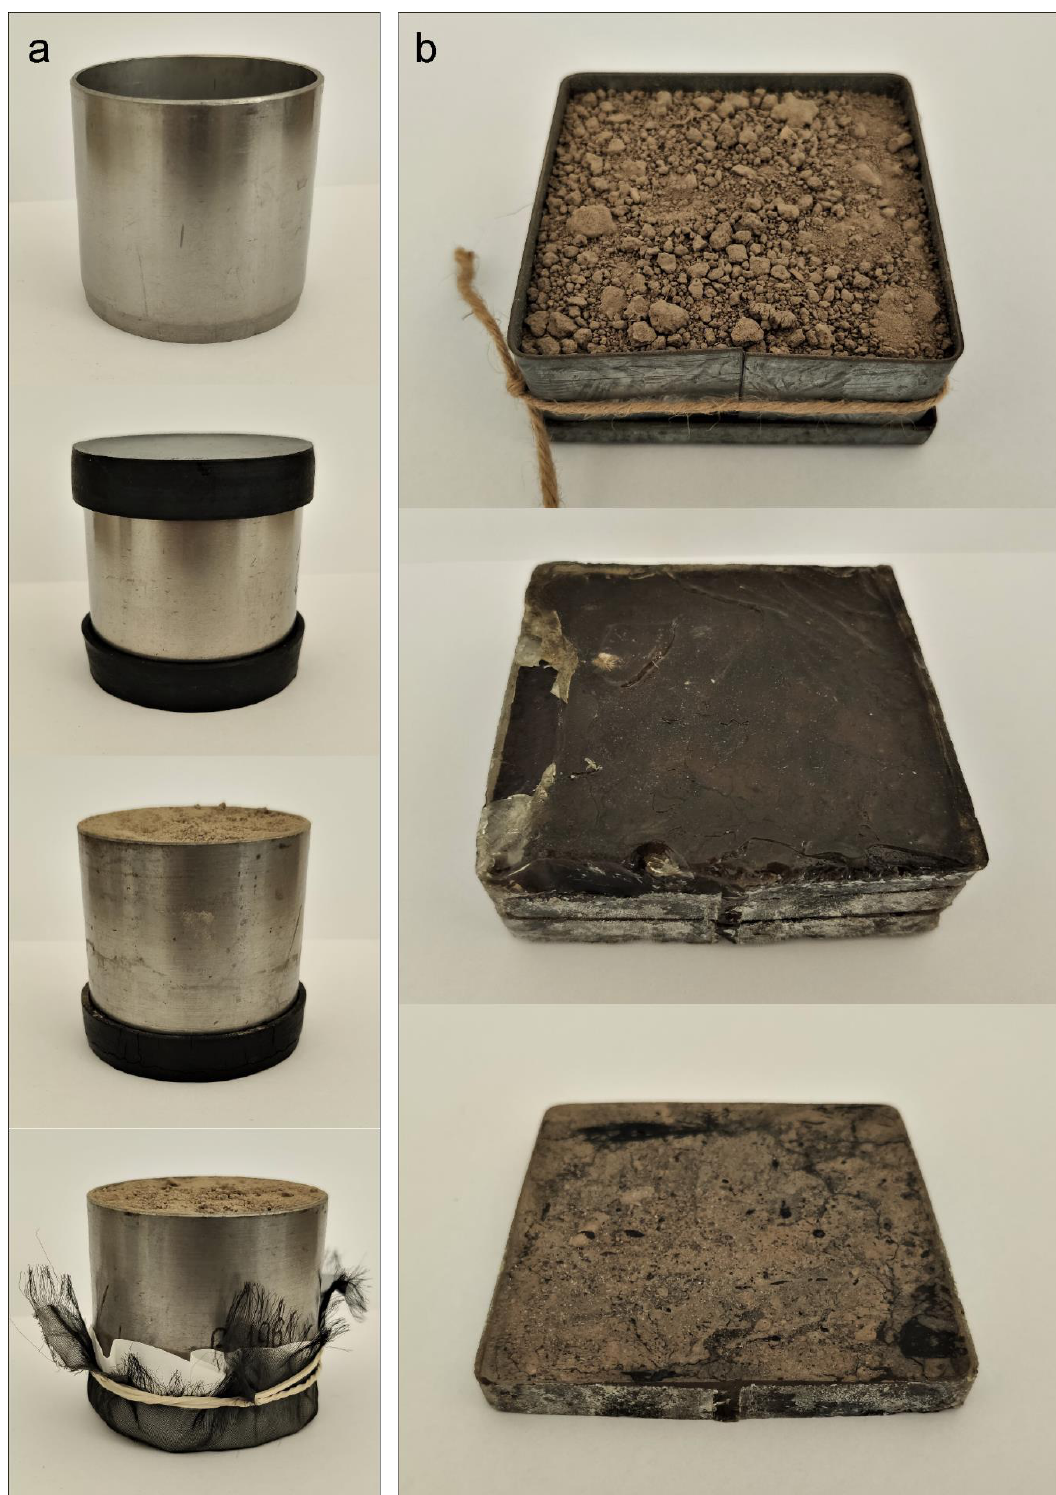
Figure 1. ( a ) Photograph of a steel cylinder measuring ca. 5 cm × 5.1 cm (diameter × height) used to determine air